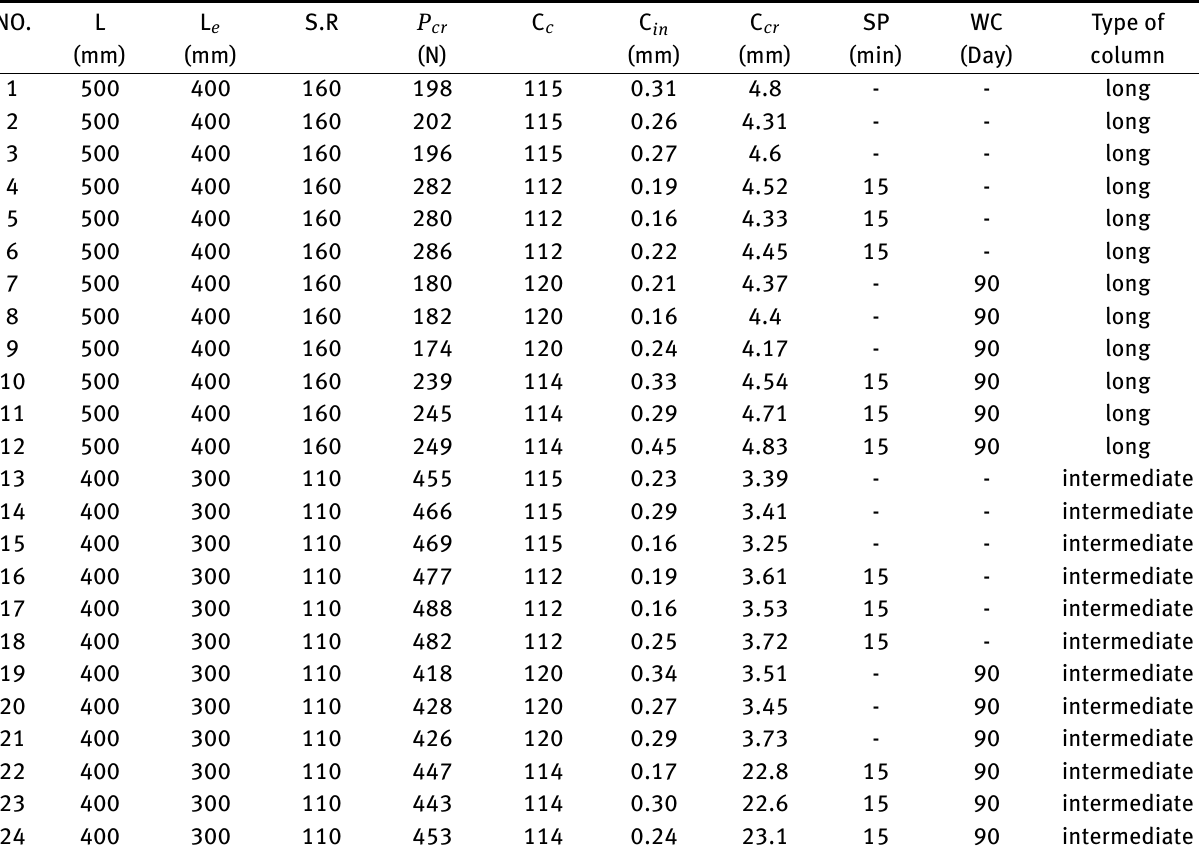
Table 5: The results of 24 columns under buckling only and buckling shot peening interaction for both columns long and intermediate for 5 mm diameter and area 19.634 mm 2 and 15 min. SP time